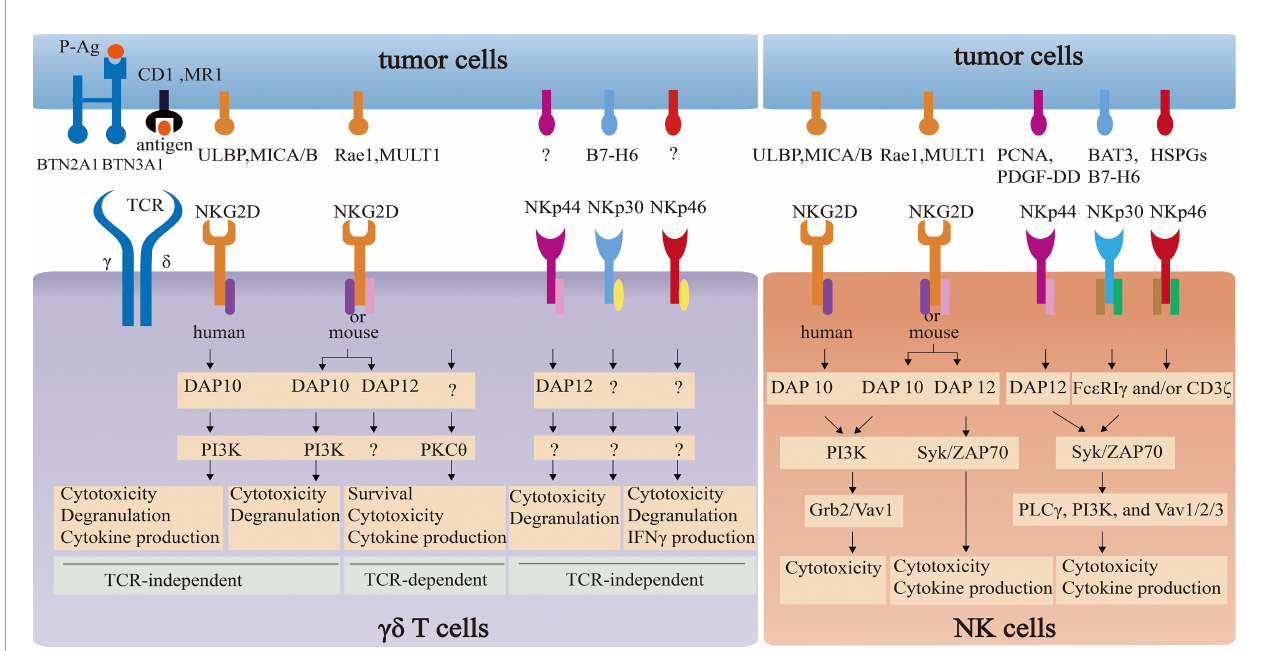
FIGURE 3 | The comparison of NKG2D and NCR signaling pathways between gd T cells and NK cells. NKG2D in NK cells associates with adapter DAP10 (PI3K and Grb2-Vav1 signaling) or DAP12 (Syk/ZAP70 signaling) to directly induce cytotoxicity and/or cytokine release. NKG2D in gd T cells not only directly triggers cytotoxicity via PI3K-dependent pathway by coupling with DAP10, but also enhances the effector function in a TCR-independent way via PKC q . However, the impact of NKG2D-DAP12 complex on the function on gd T cells remain elusive. NCRs in NK cells and gd T cells can induce cytotoxicity activity. However, signaling pathways of NCRs-ligands in NK cells are well-understood, which in gd T cells remain